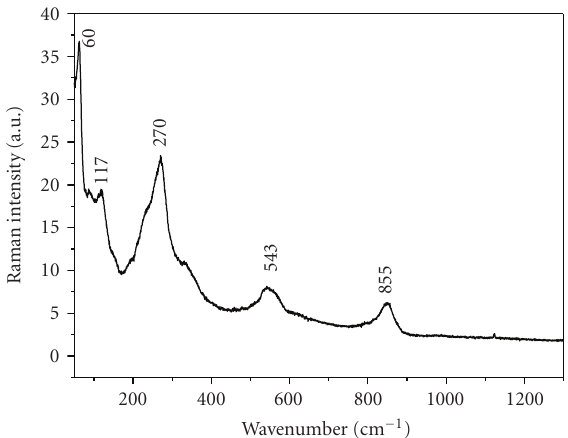
Figure 4: C - V curve of SBTi film annealed deposited by the soft chemical method at 700 ◦ C for 2 hours.